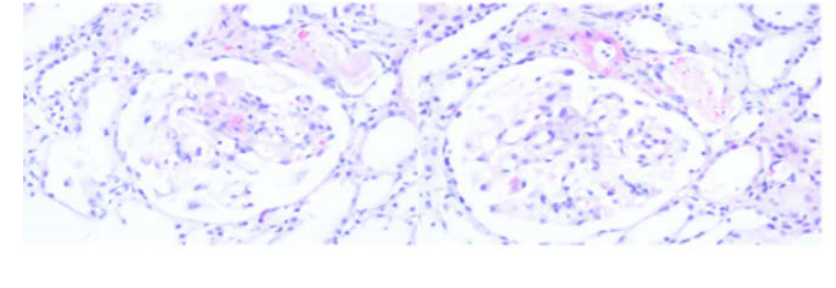
Figure 1. Renal biopsy; histological examination of biopsy revealed fibrinoid material on the afferent arteriole of the glomerulus and fragmented erythrocytes on one segment of the capillary specimen and minor inflammation at in the interstitium.